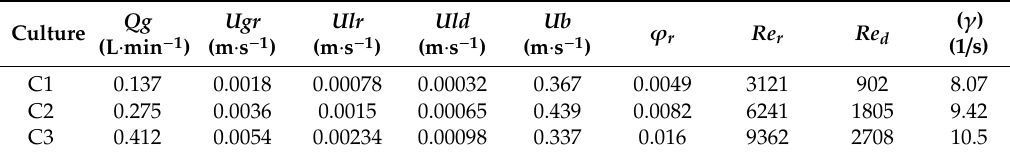
Figure 4. E ff ect of the flow rate on the growth of S. dimorphus and the pH. Figure 4. Effect of the flow rate on the growth of S. dimorphus and the pH . Table 3. E ff ect of the superficial gas velocity Ugr on the hydrodynamic parameters in each of the airlift bioreactors.